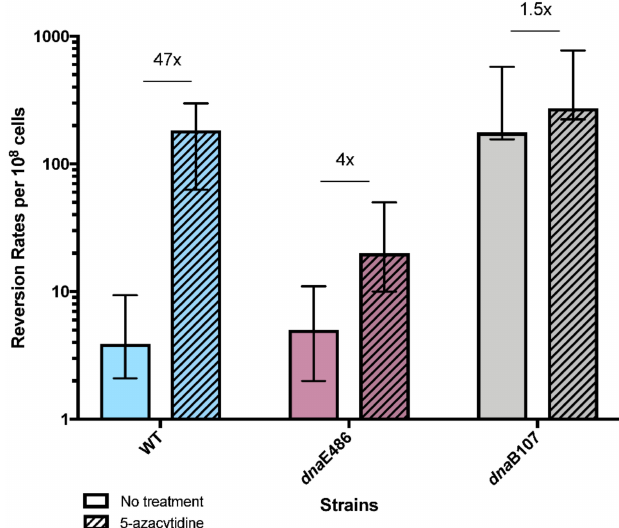
Figure 6. Reversion rates of lacZ quasi-palindromic (QP) WT, dnaE486 and dnaB107 leading strand mutational reporter after treatment with 5-azacytidine. Data show reversion rates per 10 8 cells from multiple trials performed in different days. Error bars represent 95% confidence interval. Reversion rates of lac Z QP wild-type, dnaE486 , and dnaB107 mutant strains, grown at 30 ◦ C, with and without treatment with 25 µ g/mL of 5-azacytidine. Rates for no treatment are 3.9, 5.0, and 176, respectively. Rates with 5-azacytidine are 183, 20, and 273, respectively. Fold change comparing rates of reversion with and without exposure of 5-azacytidine is indicated above bars, and are 47, 4, and 1.5,